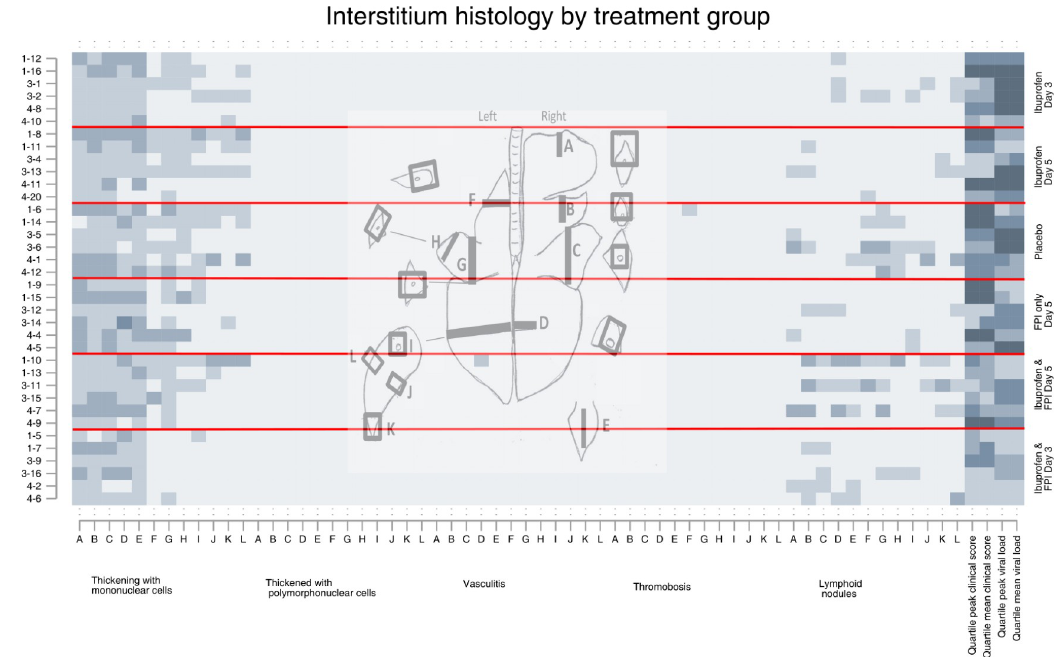
Fig 7. Interstitium histology findings by drug treatment group. Each row represents an individual calf, each letter represents a slide, the x-axis colors indicate a different specific histological finding. The shading of each pixel represents the severity of the finding on a scale of 0 (light) to 3 (darker). On the y-axis the first number represents the batch/replicate number, the number following the dash the ear tag for the individual calf. The horizontal red lines divide the treatment groups. The last four columns represent quartiles (first lightest, fourth darkest) of mean peak and clinical scores and mean peak viral loads measured by nasal swabs.